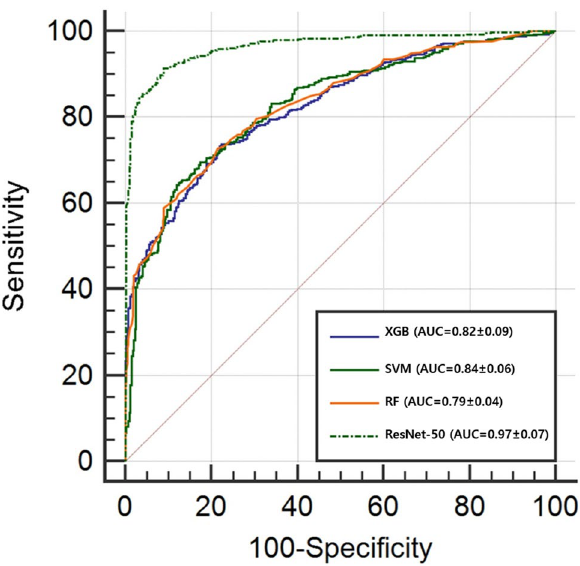
Figure 8. Mean ROC comparison graph of fivefold cross validation of each method to predict cervical